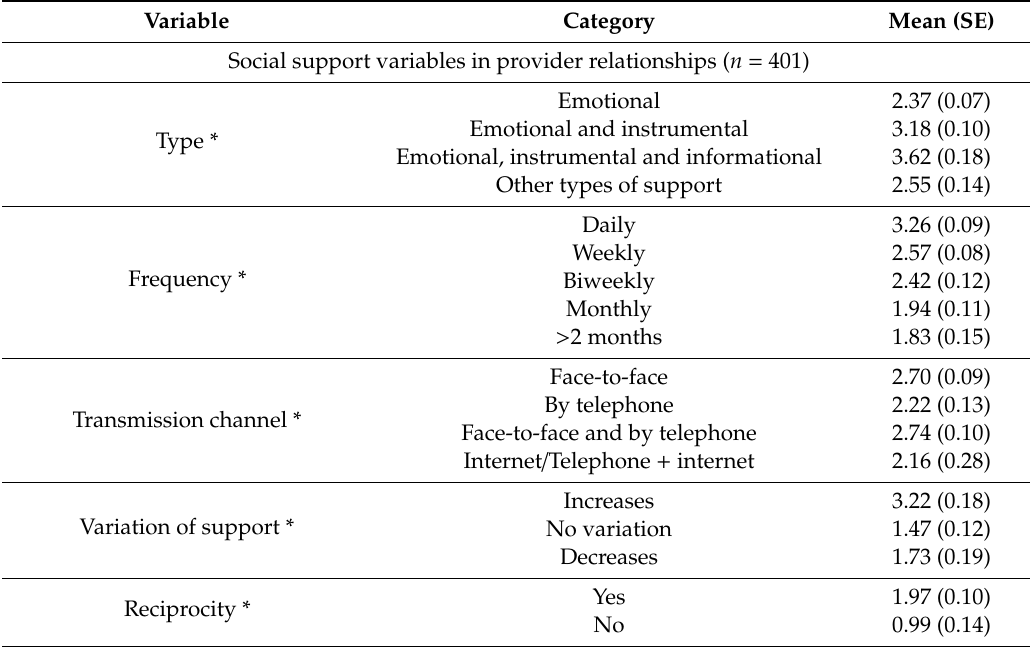
Table 3. Satisfaction and social support